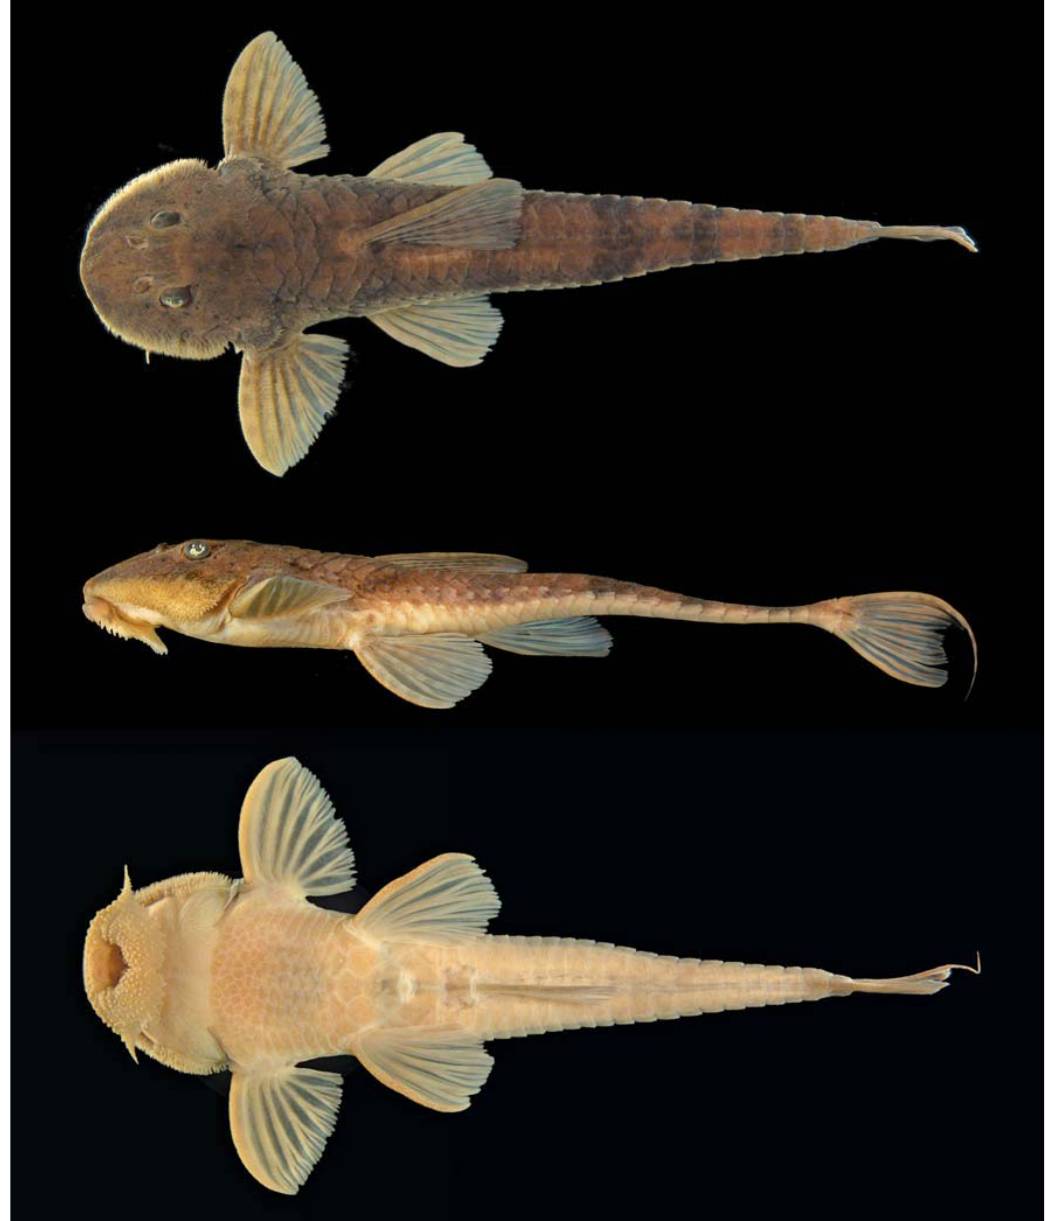
Fig. 1. Rineloricaria osvaldoi , holotype, MZUSP 89022, male, 126.3 mm SL; rio Vermelho, rio Araguaia basin, Brazil; dorsal, lateral and ventral